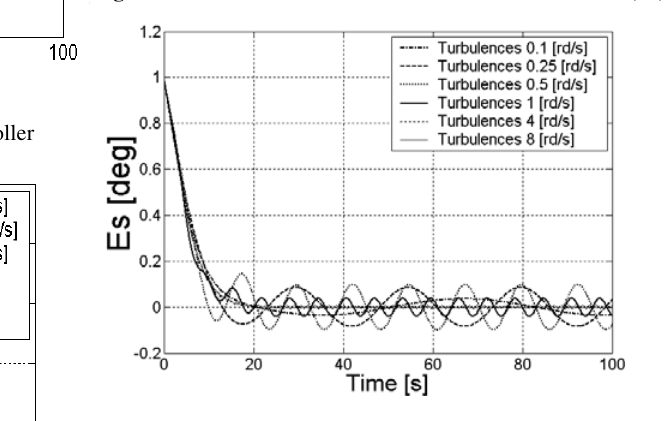
Fig 8d. Influence of turbulence with the use of control law (14)